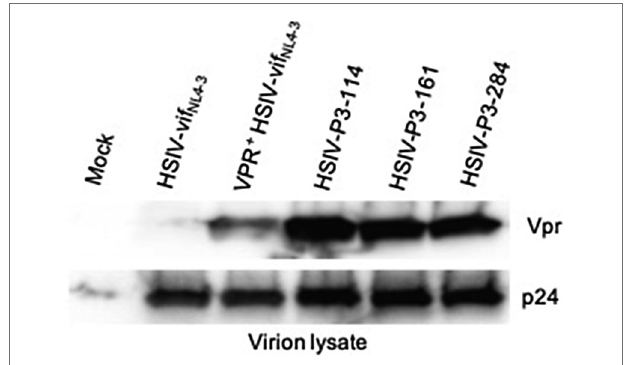
FIGURE 7 | Vpr expression from HSIV-P3 IMCs clones. 293T cells were transfected with HSIV-P3 IMCs. At 48 h post-transfection, virus supernatants were collected and concentrated by centrifugation. Virion lysates were analyzed by western blot using antibody to HIV-1 Vpr and